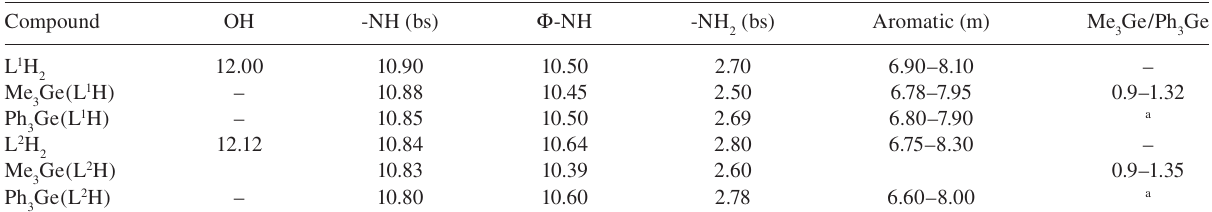
and L 2 H ) and their triorganogermanium(IV) complexes. 2 2